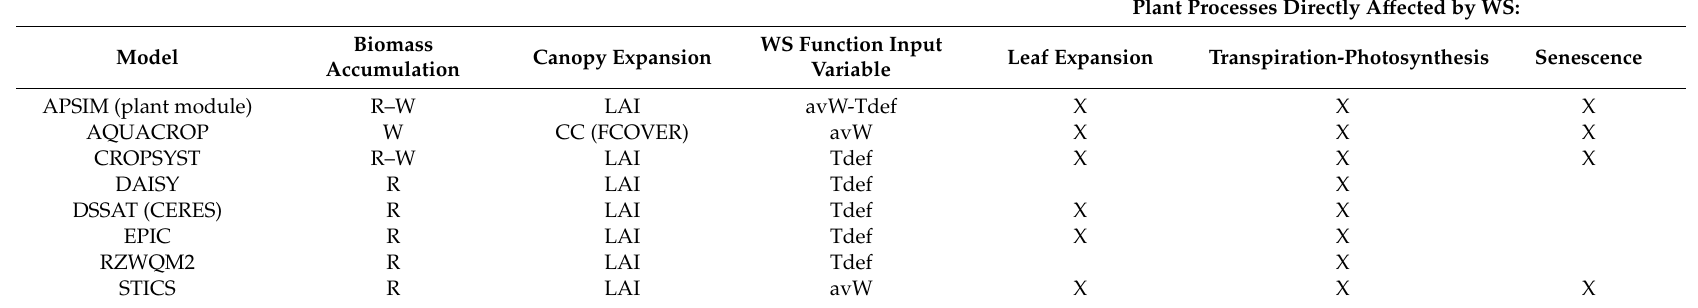
Table 2. Summary of the relevant crop models’ features discussed in the paper. R: radiation-driven; W: water driven; R–W: radiation–water hybrid approach (the minimum is kept); LAI: leaf area index; CC: canopy cover (usually called FCOVER in RS); avW: available water (above PWP); Tdef: transpiration deficit (Ta / Tp). Crosses indicate that the model simulates the direct e ff ects of water stress on the specific plant growth or development process. Plant Processes Directly A ff ected by